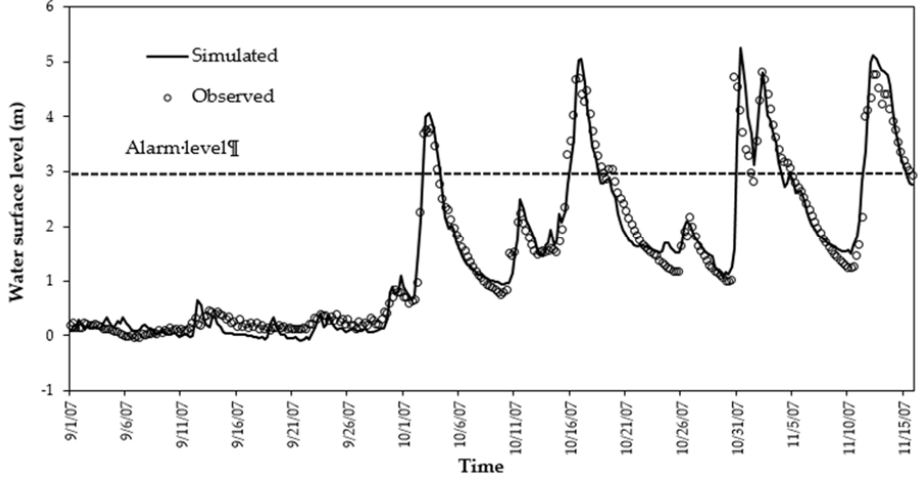
Figure 5. Comparison between simulated and observed water surface levels for the 2007 flood season at the Phu Oc gauging station located in the Huong floodplain.